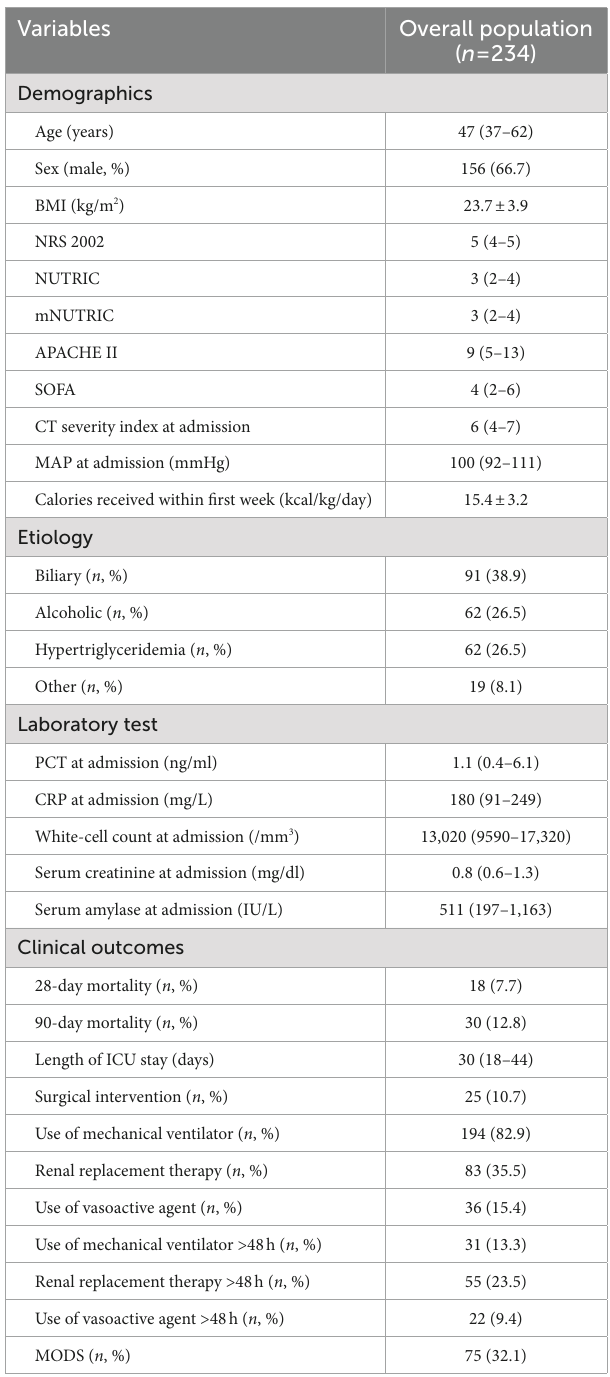
TABLE 1 Patient characteristics.